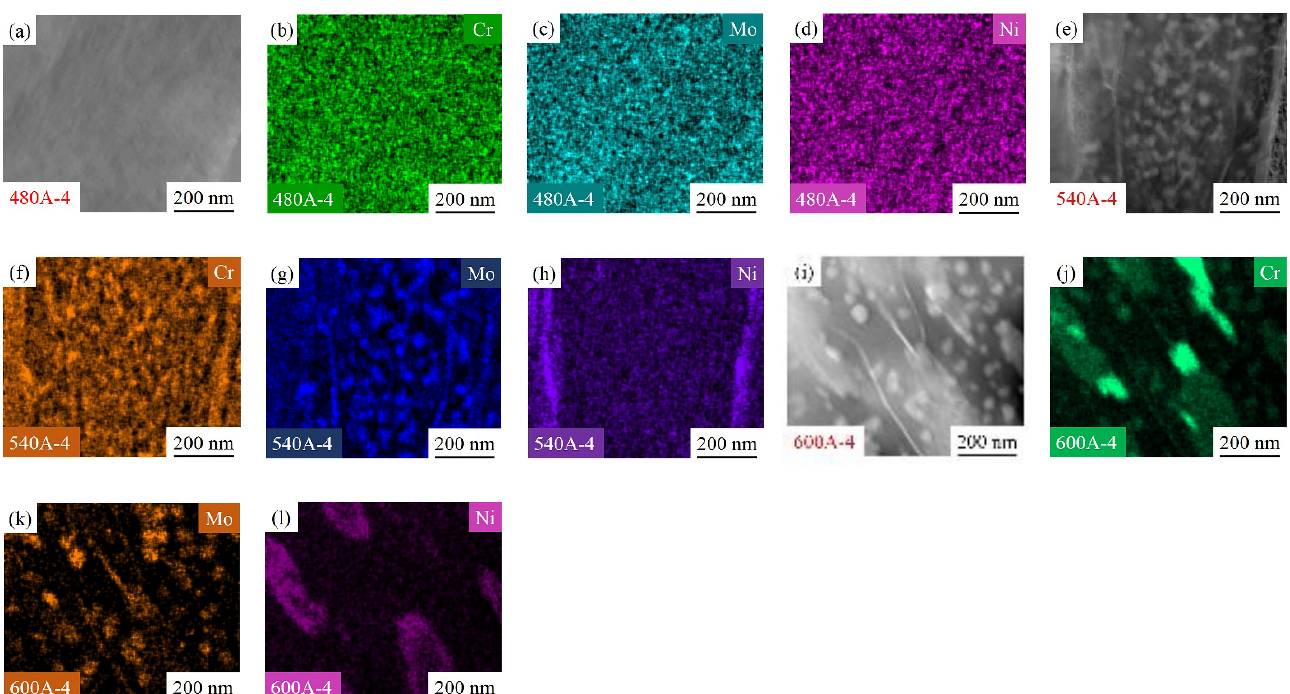
Table 5. Quantitative analysis results of the second phase in the sample.